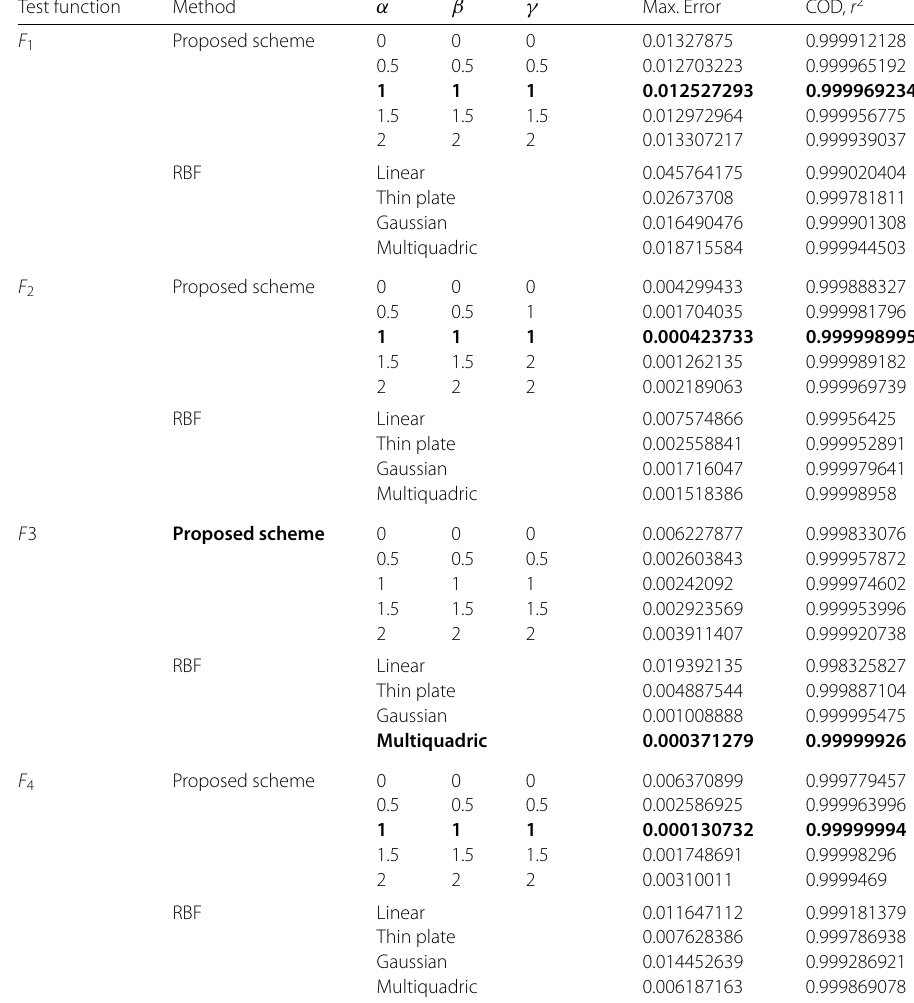
Table 3 Error measurement for 100 data points